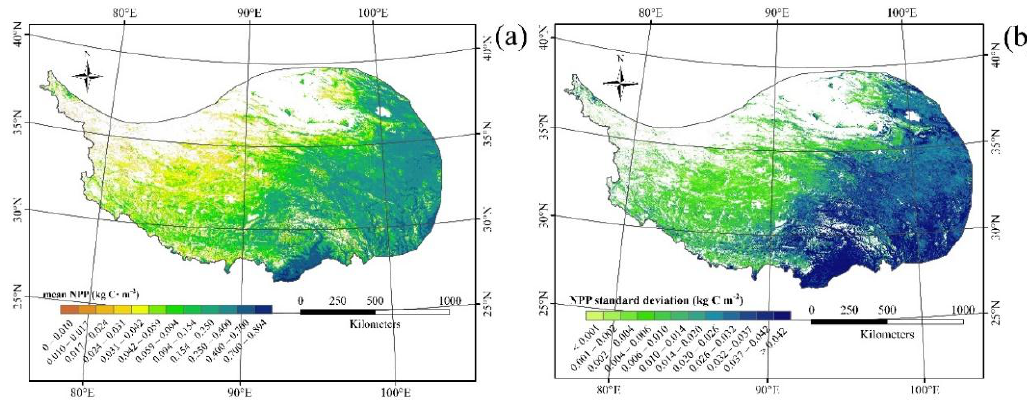
Figure 2. ( a ) Spatial patterns of mean NPP and ( b ) standard deviation in the Tibetan Plateau between 2001 and 2015.